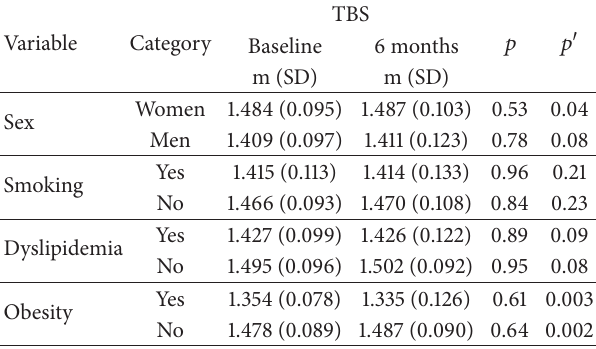
Table 2: Main baseline epidemiological characteristics of the